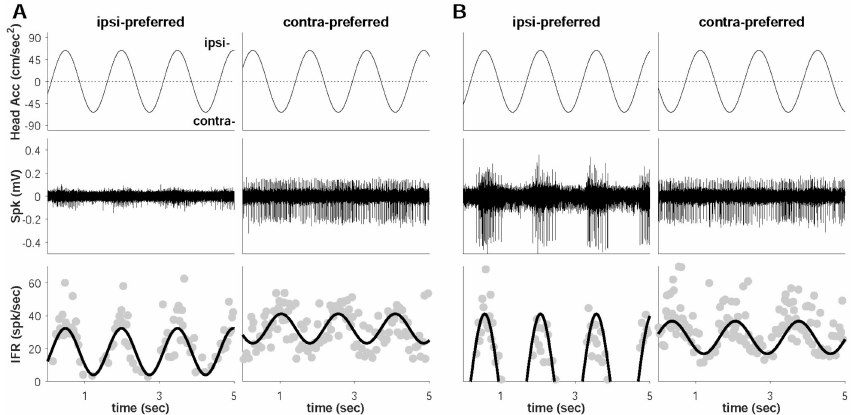
Figure 3. Ipsi- and contra-preferred neuronal examples responding to head acceleration. ( A ) Exam- ples of neuronal responses from sham. ( B ) Examples of neuronal responses from labyrinthectomy model. At the bottom, the gray dots represent IFR, and the black line indicates their relevant curve-fitting based on Equation (1).